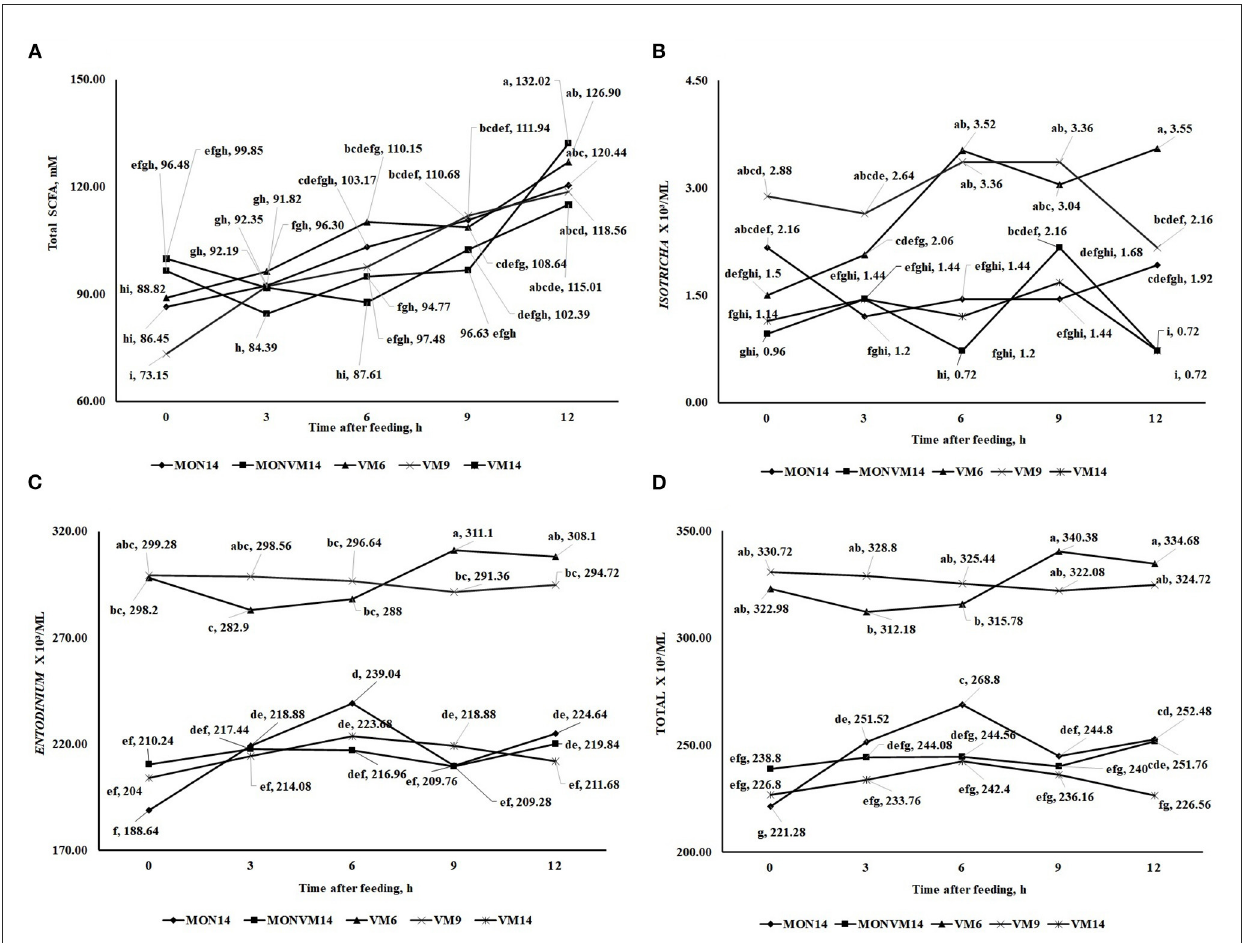
FIGURE2 This is a figure with sub figures. (A) Interaction between treatments and hours after the treatment 1 on the concentration of total (SCFA) fatty acid chain (mM) of rumen-cannulated Nellore cattle fed high-concentrate diets containing sodium monensin (MON), virginiamycin (VM) or both on the 16th day of the experimental period. (B) Interaction between treatments and hours after treatment on total ruminal Isotricha count (ml3/ml) of rumen-cannulated Nellore cattle fed high-concentrate diets containing sodium monensin (MON), virginiamycin (VM) or both on the 16th day of the experimental period. (C) Interaction between treatments and hours after treatment on total ruminal Entodinium count (ml3/ml) of rumen-cannulated Nellore cattle fed high-concentrate diets containing sodium monensin (MON), virginiamycin (VM) or both on the 16th day of the experimental period. (D) Interaction between treatments and hours after treatment on total ruminal protozoan count (ml3/ml) of rumen-cannulated Nellore cattle fed high-concentrate diets containing sodium monensin (MON), virginiamycin (VM) or both on the 16th day of the experimental